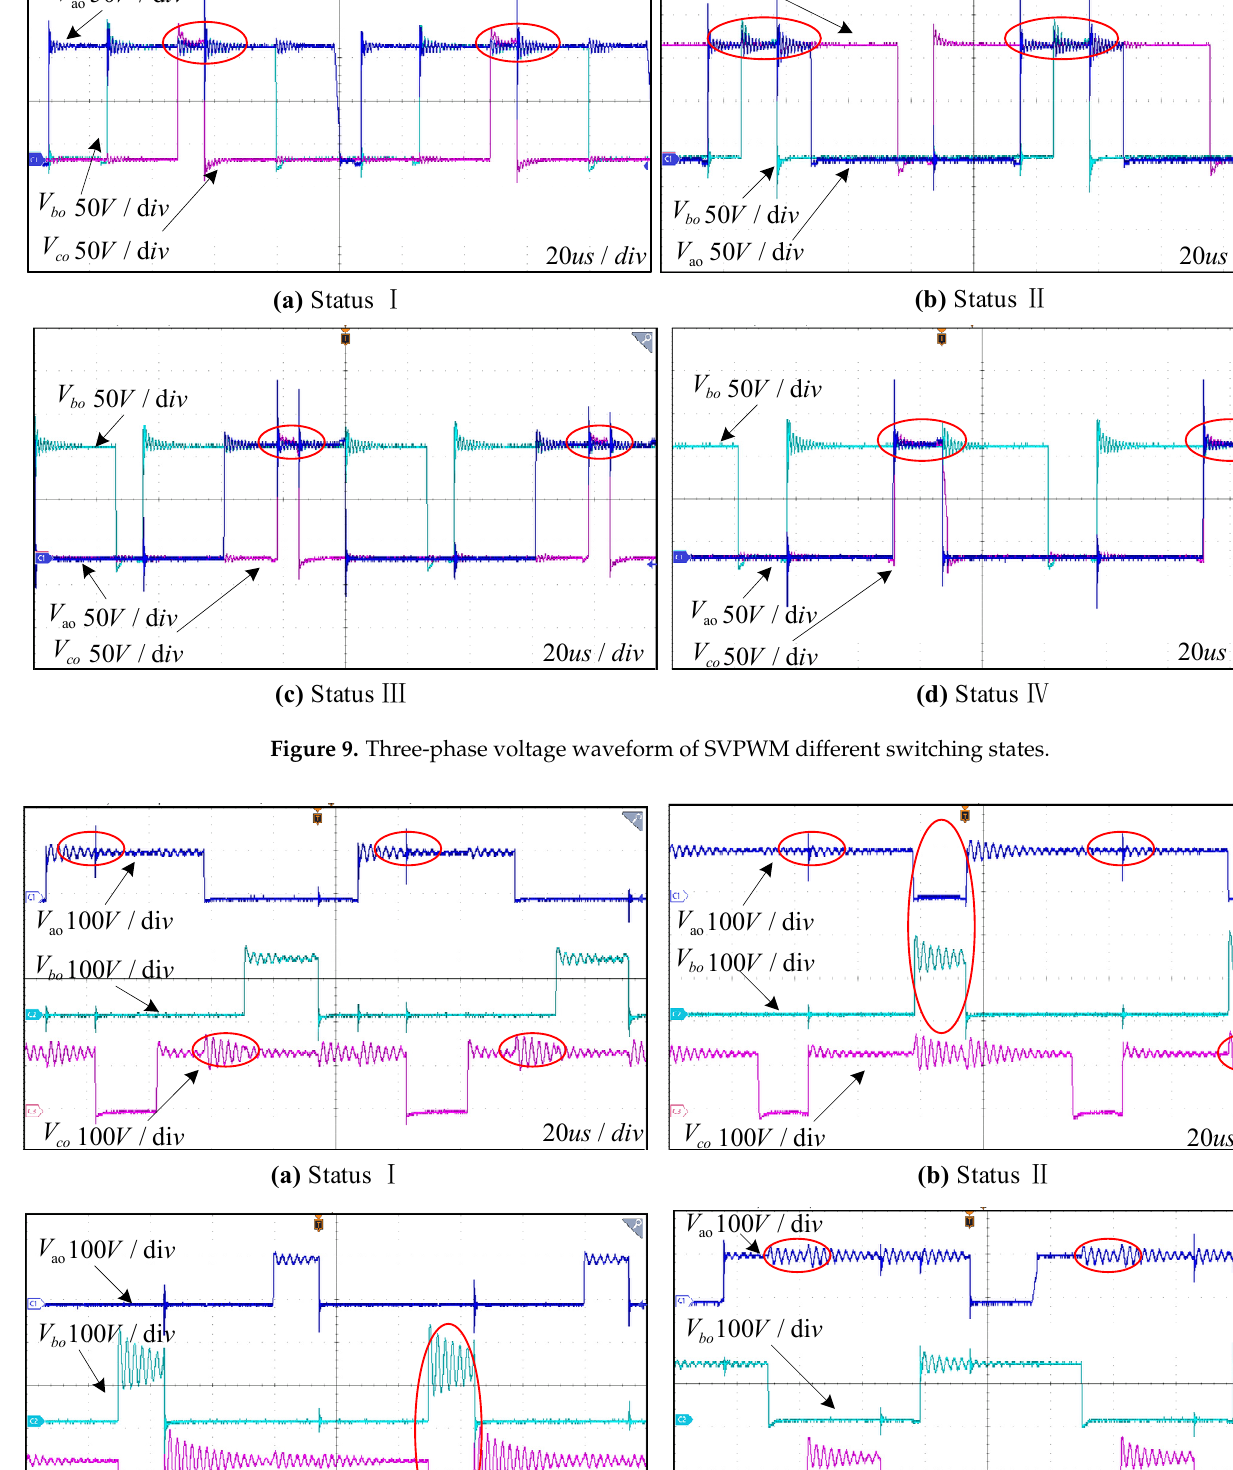
Figure 8. Experimental platform.